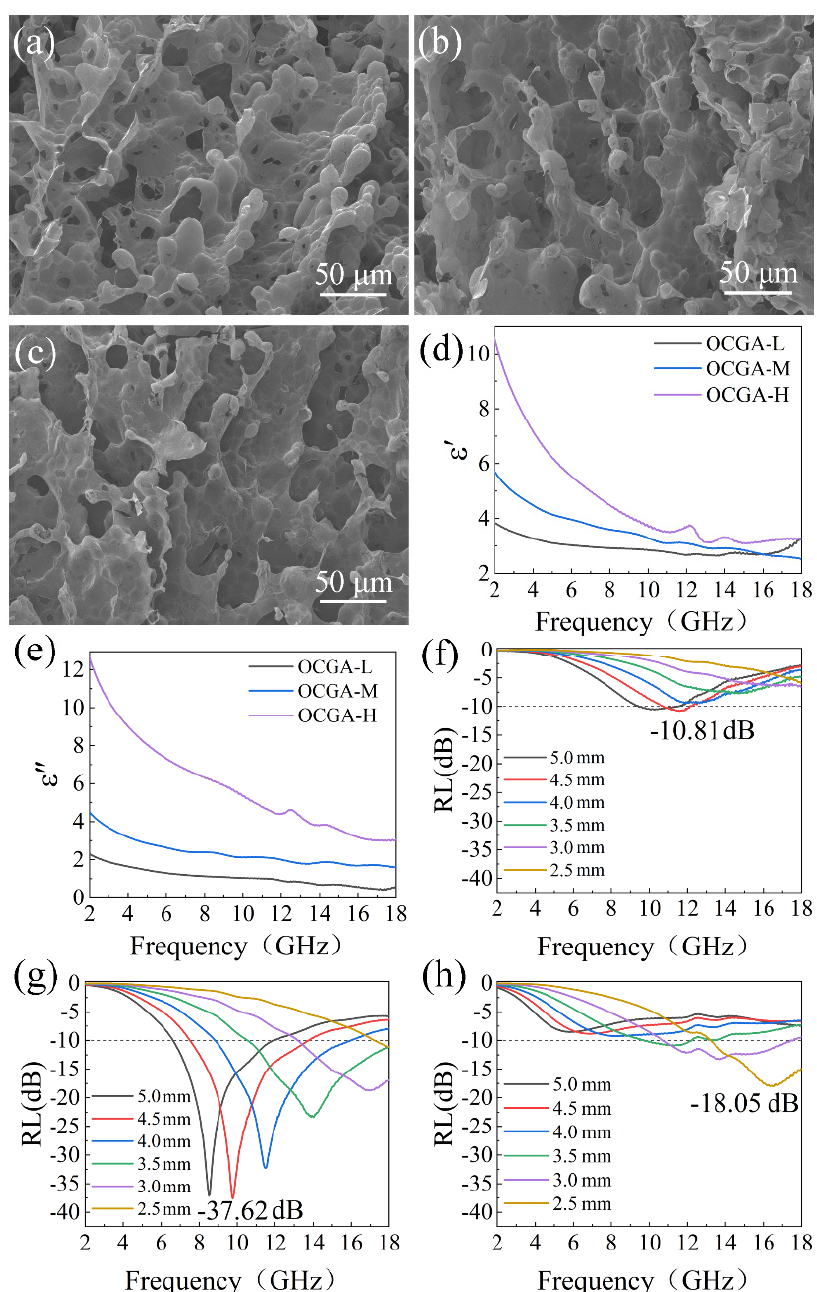
Figure 4. Characterization of OCGAs with different graphene framework. SEM images of ( a ) OCGA-L, ( b ) OCGA-M and ( c ) OCGA-H. ( d ) Real part ( ε ′ ) and ( e ) imaginary part ( ε ″ ) of permittivity, and RL of ( f ) OCGA-L, ( g ) OCGA-M and ( h ) OCGA-H. The microwave absorption performance was calculated and shown in Figure 4f–h. The OCGAs with the lowest or highest density did not show the best microwave absorption ability. This is because that the dielectric loss of OCGA-L is too poor, so a larger thickness is required to reach the RL min . For OCGA-H with higher dielectric loss, most microwaves cannot enter inside this dense aerogel due to the mismatched impedance. Proper dielectric loss and good impedance matching (Figure S1) are obtained in OCGA-M, which reaches a RL min of − 37.62 dB at the matched thickness of 4.5 mm and the largest EAB of 7.07 GHz at the matching thickness of 4.0 mm. Thus, the OCGA with medium density was adopted in the follow-up